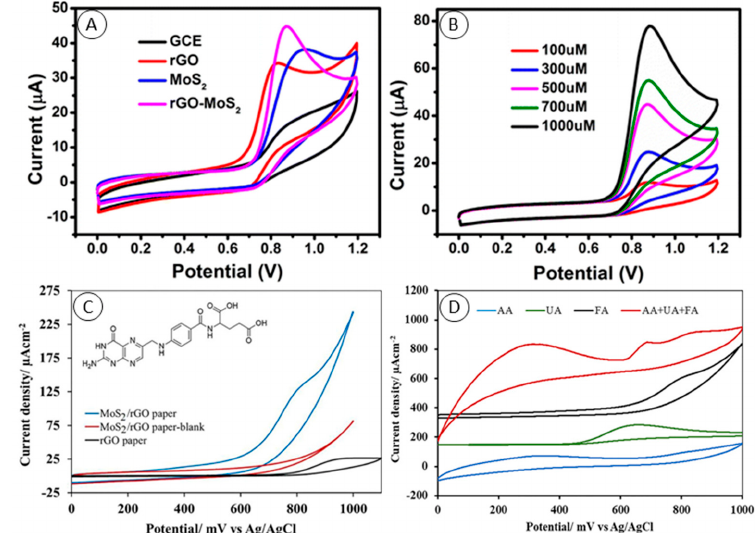
Figure 3. ( A ) Cyclic voltammetry CV curves of the glassy carbon electrode (GCE), GCE modified with rGO, MoS 2 and rGO/MoS 2 in 0.1 M PBS (pH = 7.0) with 500 μ M nitrite. ( B ) CV curves of the GCE modified with rGO/MoS 2 in 0.1 M PBS (pH = 7.0) under different concentrations of nitrite: 100, 300, 500, 700, and 1000 μ M (scan rate: 50 mV ∙ s − 1 ). Both from Hu et al. [55]. ( C ) CV curves of rGO (black) and rGO/MoS 2 paper electrodes in 0.1 M PBS (pH 7.0) with (blue) and without (red) 2.0 mM folic acid (FA). Scan rate: 50 mV ∙ s − 1 . Inset: Structure of FA. ( D ) The CVs of the same concentrations of ascorbic acid (AA, blue line), uric acid (UA, green line) and FA (black line) and 1.0 mM AA, 0.5 mM UA and 0.5 mM FA containing solution (red line) at the rGO/MoS 2 composite paper electrode in pH 7.0 PBS. Scan rate: 50 mV ∙ s − 1 . Both from Kiransan et al. [59].